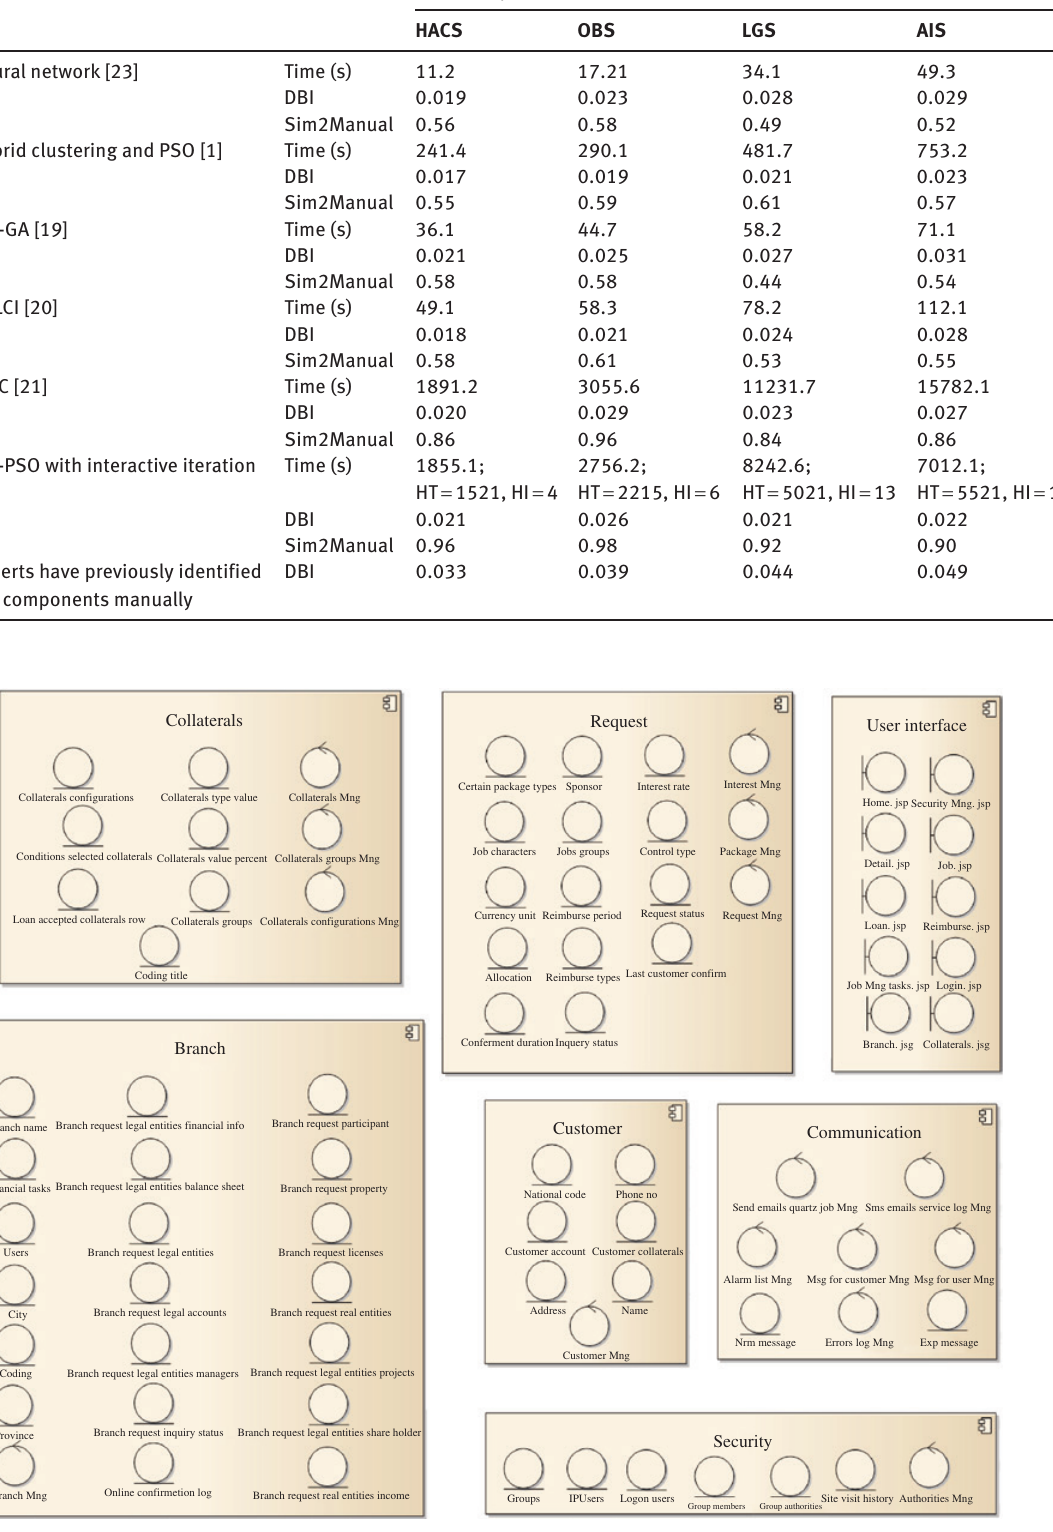
Table 4: Results of Neural Network, Hybrid, SCI-GA, SBLCI, CCIC, and PCI-PSO Methods for the Four Cases. Method